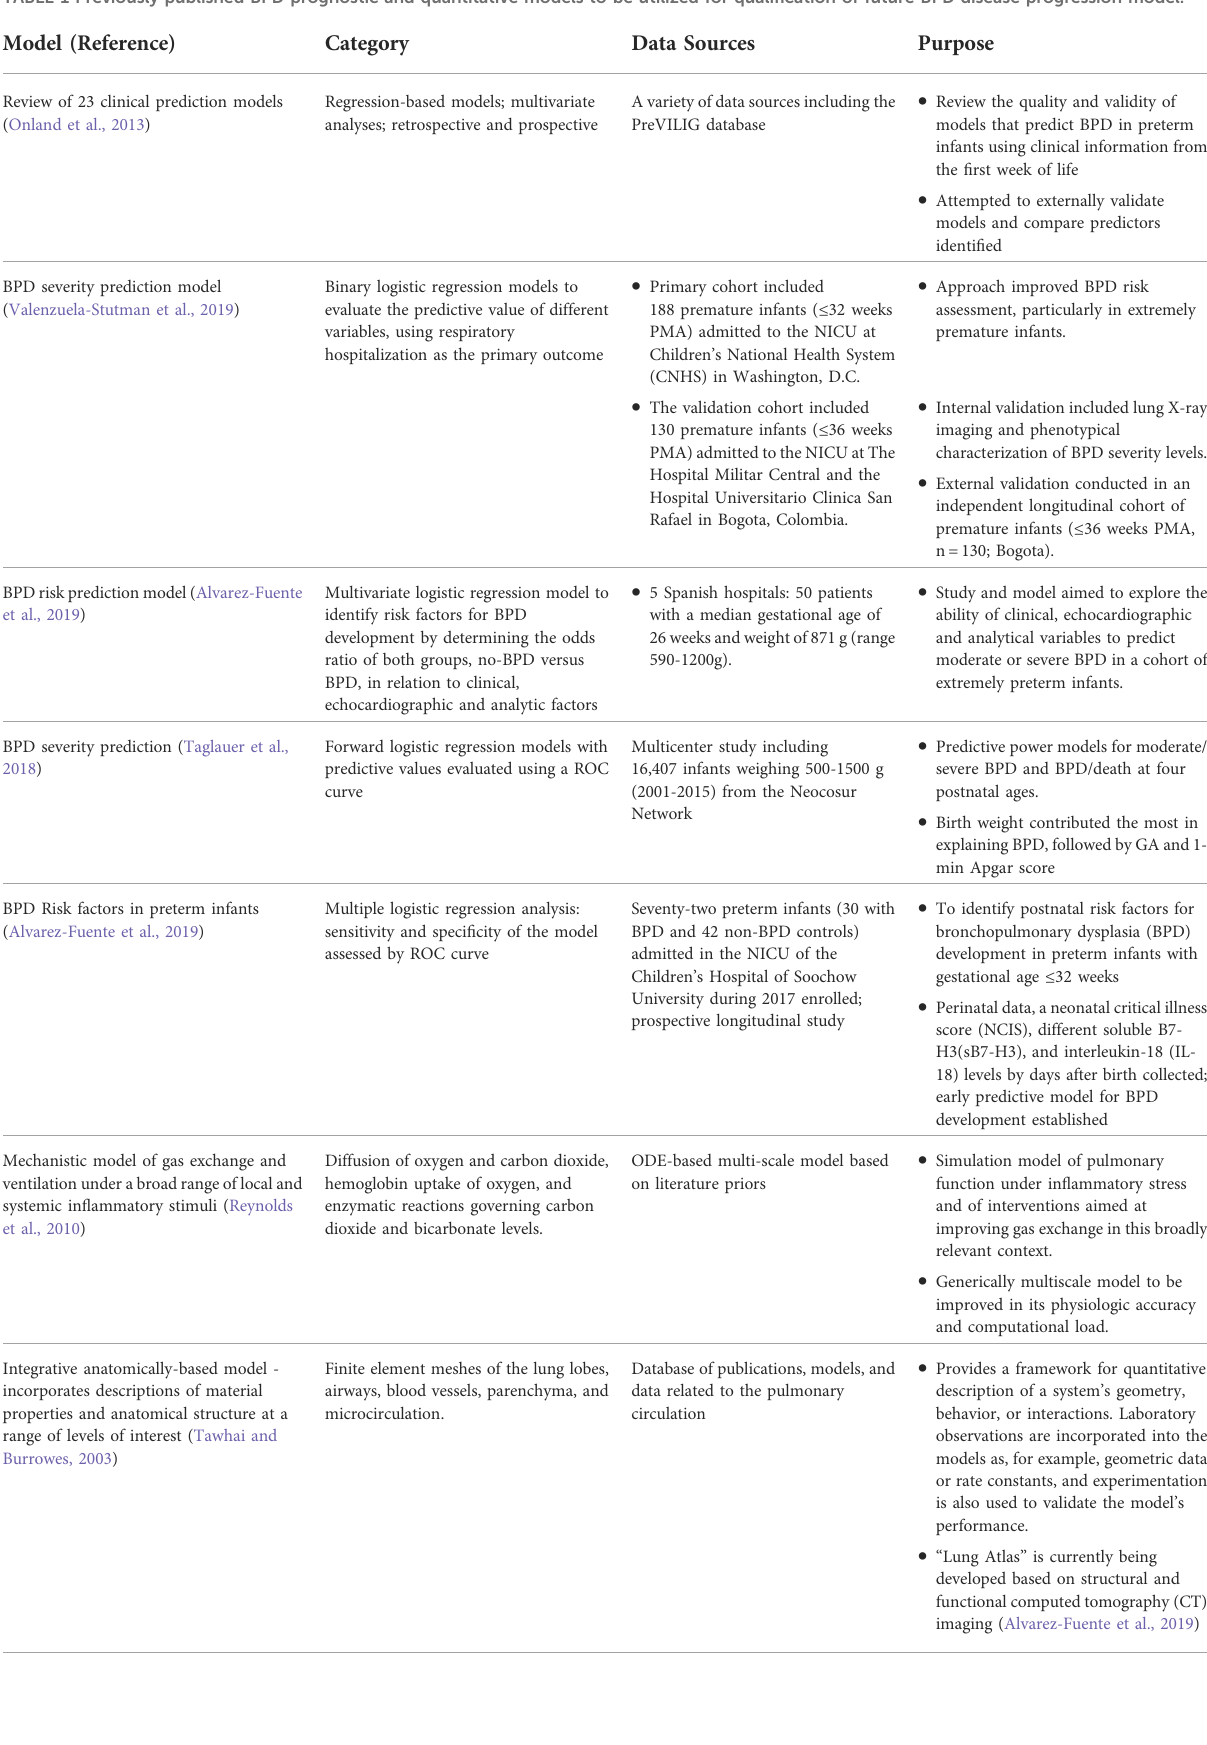
TABLE 1 Previously published BPD prognostic and quantitative models to be utilized for quali fi cation of future BPD disease progression